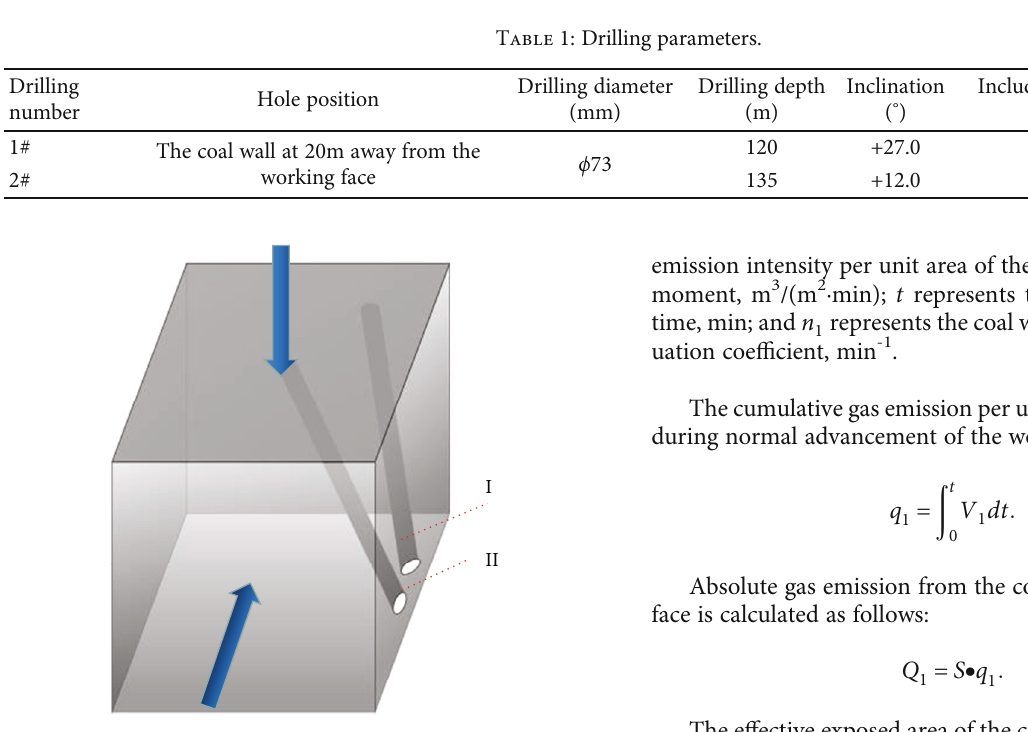
Figure 5: Schematic of the